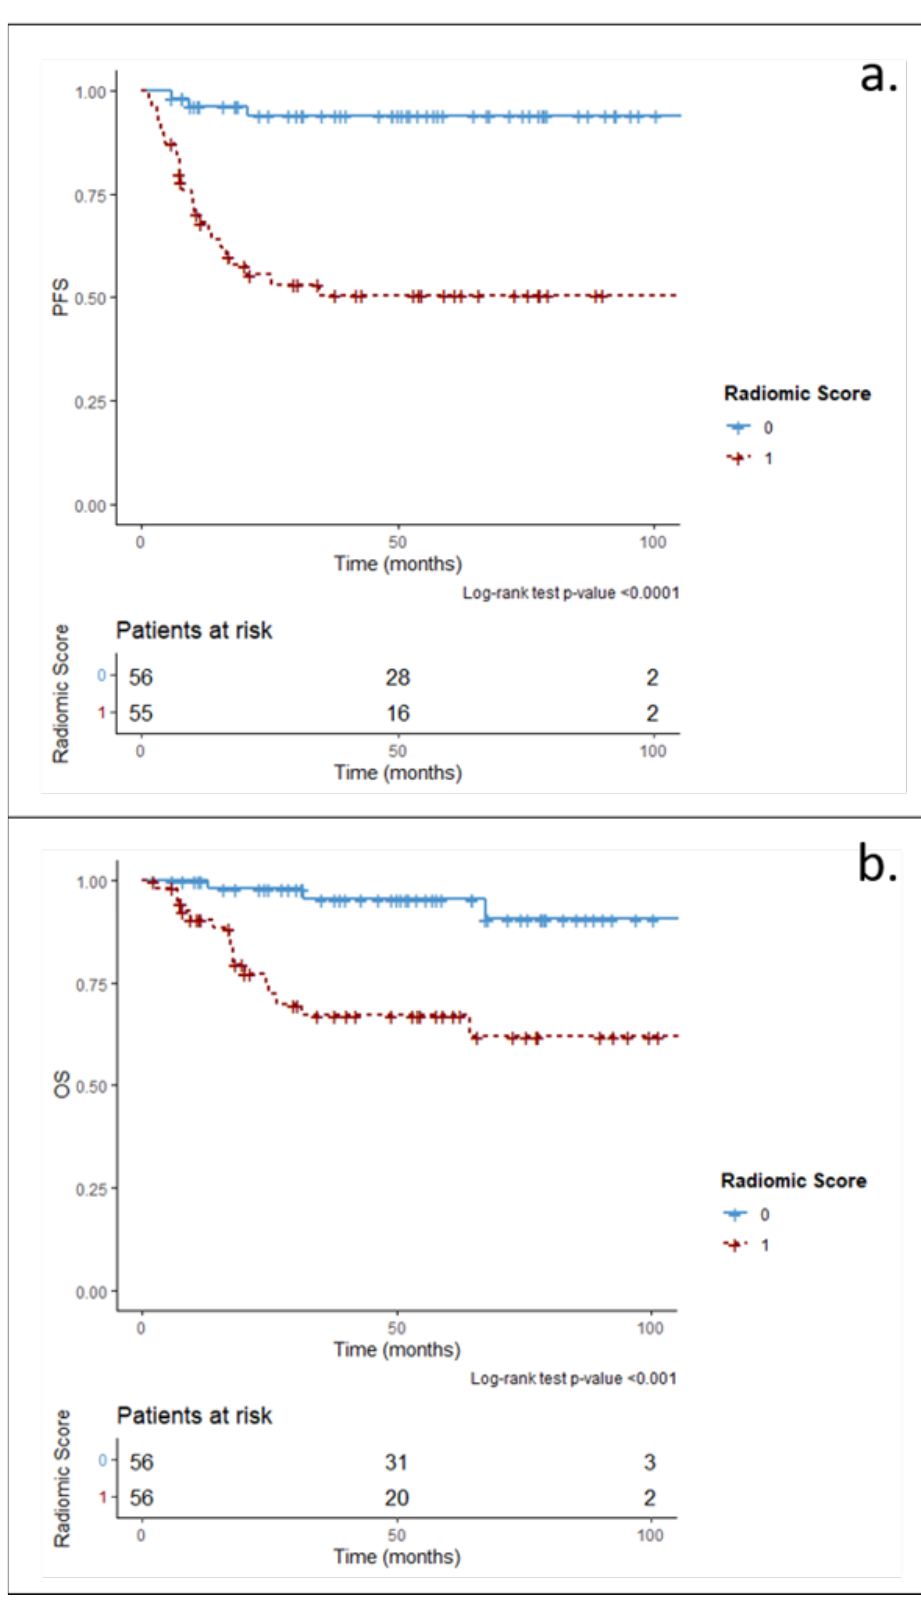
Figure 2. Univariate association (log-rank rank test) between dichotomized RS and ( a ): PFS; ( b ): OS. RS were obtained from radiomic features extracted from “SUV max lesion” segmented with Method - 2.